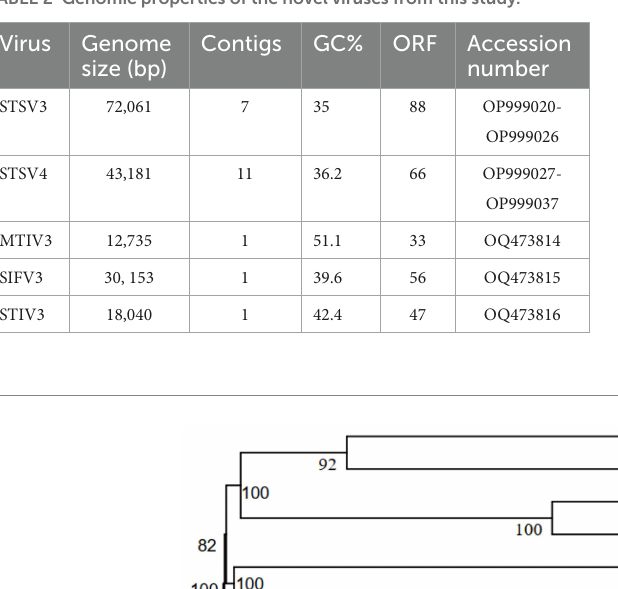
TABLE 2 Genomic properties of the novel viruses from this study.